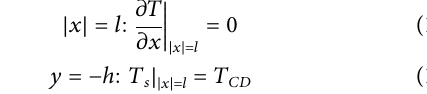
FIGURE 3 | Principal stress and temperature evolutions at the pipeline top (A σ 1 ) and bottom (C σ 1 ).